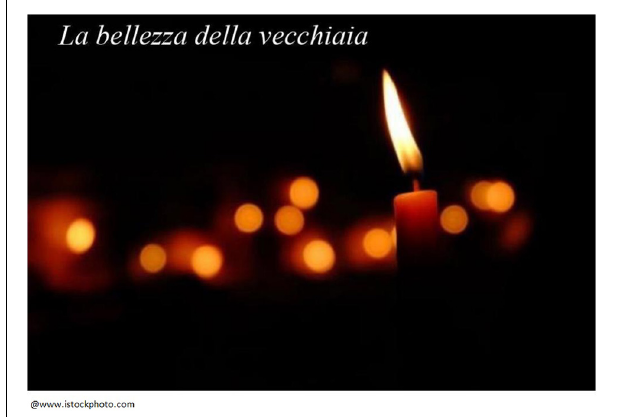
FIGURE 2 | Elena’s chosen photograph and title: “The beauty of old